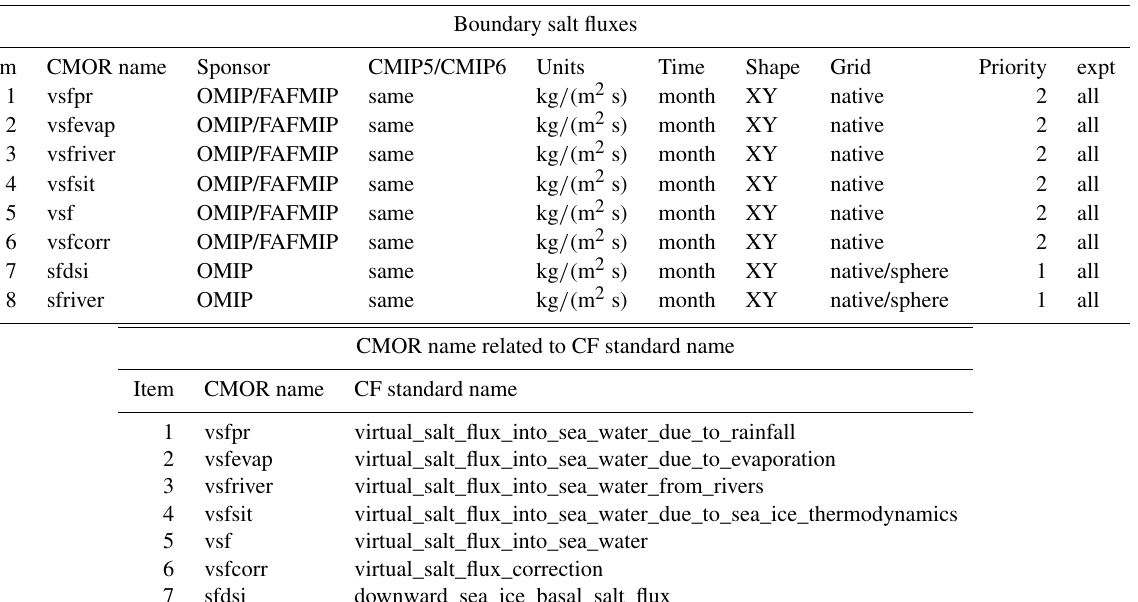
Table K2. This table provides a summary of the boundary fluxes of salt mass that should be saved from the ocean model component in CMIP6 simulations. Positive fluxes are into the ocean. The column indicating the experiment for saving the diagnostics generally says “all”, in which case we recommend the diagnostic be saved for CMIP6 experiments in which there is an ocean model component, including the DECK, historical simulations, FAFMIP, DAMIP, DCPP, ScenarioMIP, and C4MIP, as well as the ocean/sea-ice OMIP simulations. The Priority=1 diagnostics should be saved as decadal time means at decadal intervals for the piControl spin-up. Entries with grids denoted “native/sphere” denote diagnostics where native and spherical output are recommended to facilitate analysis (see discussion in Sect. A3). The lower sub-table relates the CMOR name to its CF standard